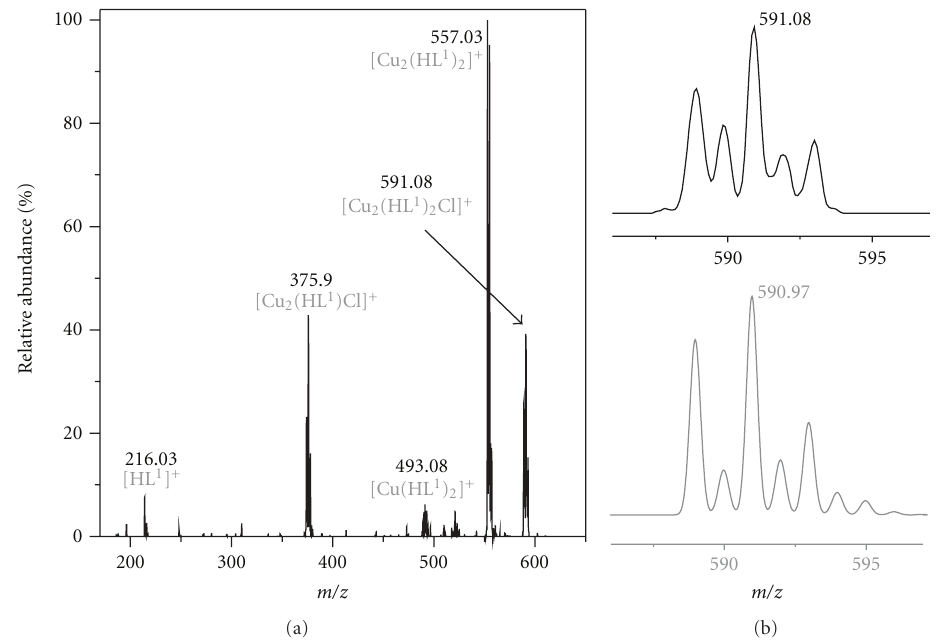
Figure 4: The MS 2 spectrum showing the fragmentation of the peak 591 m/z , the [Cu 2 (HL 1 ) 2 Cl] + fragment of 1 (left); the comparison of the measured (up) and calculated (down, in grey) isotope pattern of 591 m/z